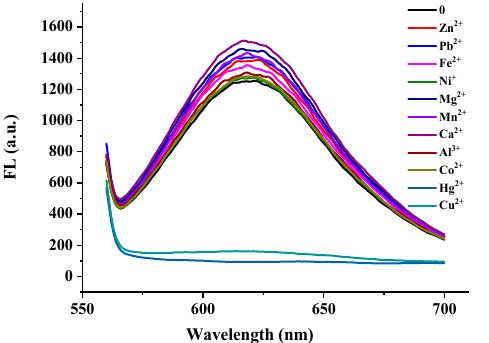
Figure 8. ( A ) The fluorescence quenching effect of DNA2-Ag NCs after adding Cu 2+ (0 nM~140 nM). ( B ) The relationships between the F/F 0 and different concentrations of Cu 2+ . ( C ) The Stern–Volmer plots of DNA2-AgNCs with Cu 2+ F 0 and F are the fluorescence intensities of the DNA2-Ag NCs in the absence and presence of Cu 2+ . ( D ) Computation of the binding constant (K) of each binding site and the number of binding sites of DNA-AgNCs (n). To evaluate the influence of other metal ions on the glyphosate detection, Zn 2+ , Fe 3+ , Pb 2+ , Ni 2+ , Mg 2+ , Mn 2+ , Ca 2+ , Al 3+ , Hg 2+ , and Co 2+ at a ten times higher concentration (600 nM) than Cu 2+ (60 nM) were tested under the same conditions. As shown in Figure 9, the